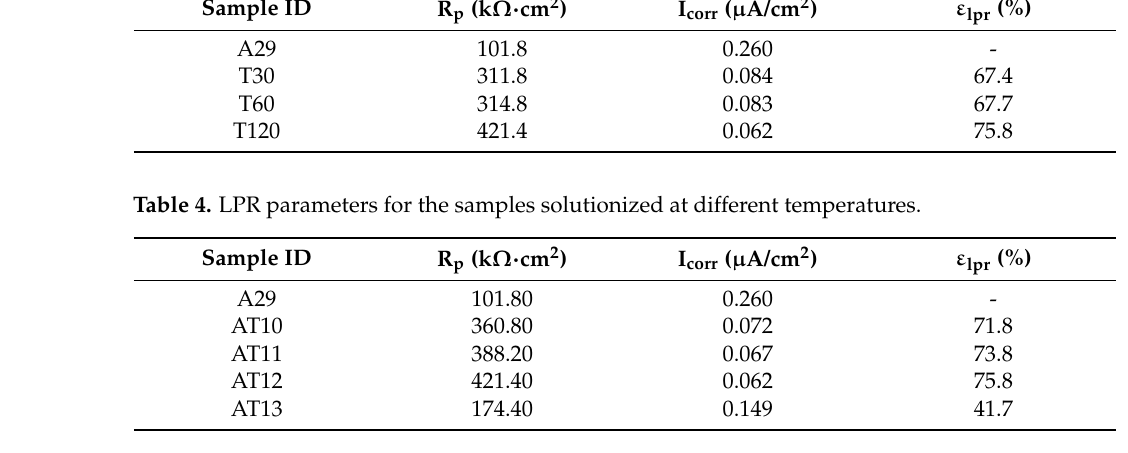
Table 3. LPR parameters for the samples solutionized for different durations .